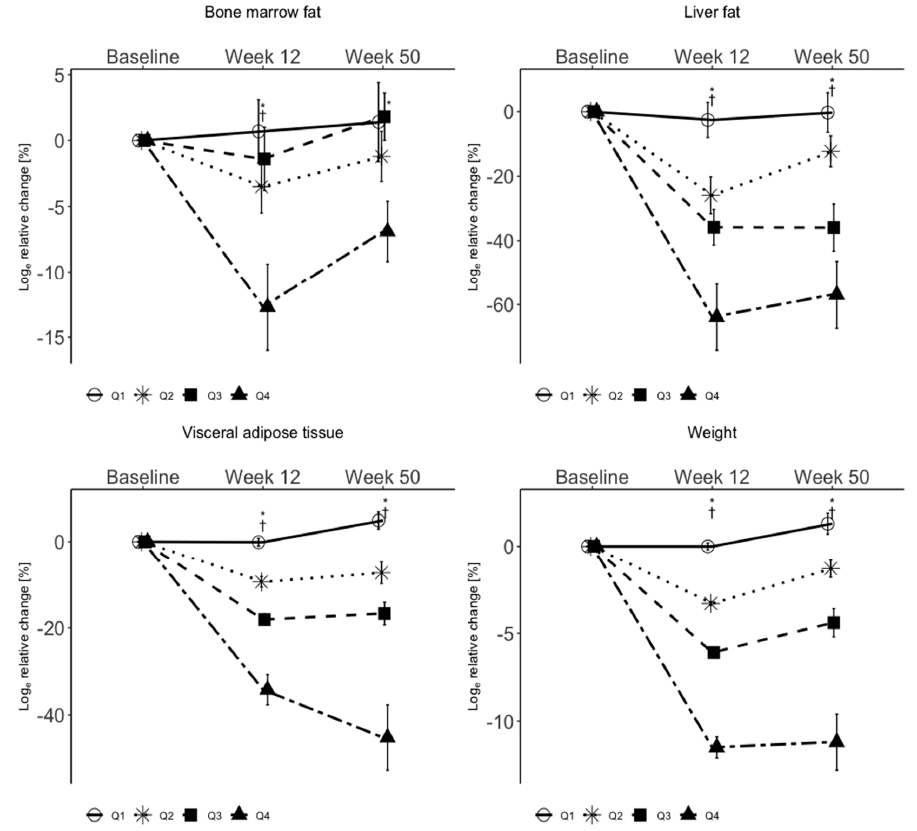
Figure 2. Relative changes of BMFC, LFC, VAT and weight by weight loss quartiles. ( A ) BMFC, ( B ) LFC, ( C ) VAT and ( D ) weight. Data are shown as mean ± SEM for Log relative change with baseline values as reference. Abbreviations: BMFC, bone marrow fat content; LFC, liver fat content; SEM, standard error of the mean; VAT, visceral adipose tissue; †, significant between the extreme quartiles 1 and 4; *, significant for all quartiles.